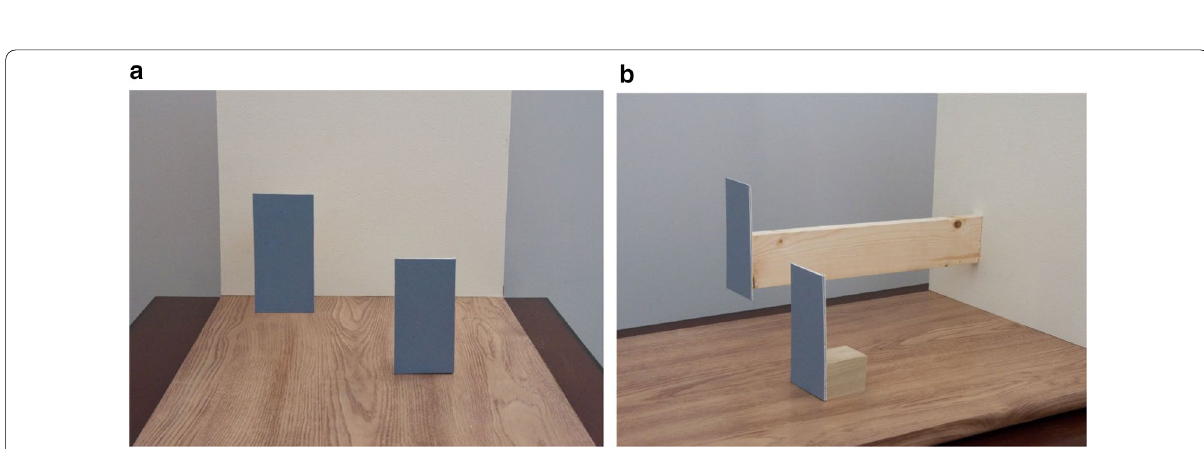
Fig. 7 Images motivated by Gibson (1950) demonstration showing that in the absence of visual information specifying lack of contact with a support surface, a target that is off the surface is perceived to be on the surface but farther away ( a ). Image ( b ) shows the actual configuration in which both objects are the same distance from the camera and the left object is raised off the surface. Created by William B.